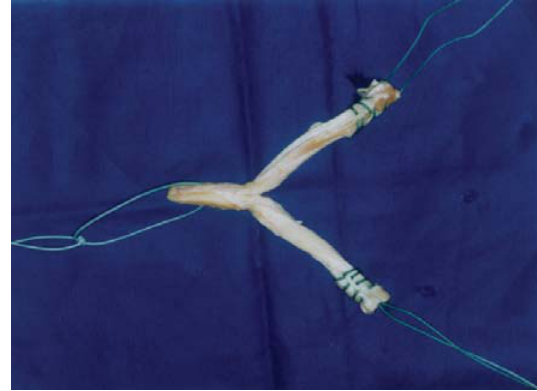
Figure 2 - Quadriceps-bone tendon graft, double bundle